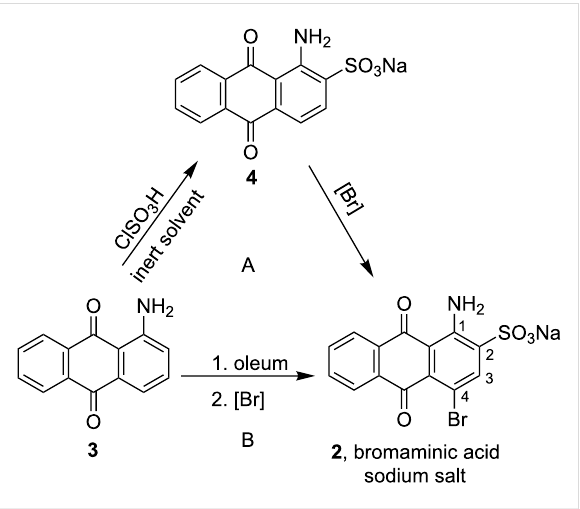
Our laboratory has a long-standing interest in the development of potent and selective purine receptor antagonists and ecto- nucleotidase inhibitors as pharmacological tool compounds to study the proteins’ functions and their potential as drug